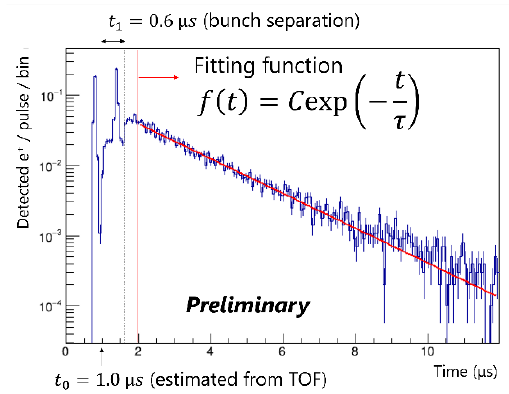
Fig. 2. Time spectrum of decay positrons in the intensity measurement of surface muons The momentum of surface muons was also measured with almost the same setup as the intensity measurement, but a magnetic field of 23.85 G was applied to an Aluminium target of various thicknesses. Due to the muon spin rotation in a magnetic field, the time spectrum of decay positrons showed a wiggled structure. In Fig. 3, the beat amplitudes are plotted as a function of the thickness of Al targets. The range of surface muons in Al was obtained by fitting this plot with an error function, and then we estimated the beam momentum to be 28.0 MeV/c (RMS 1.2 MeV/c) as expected.